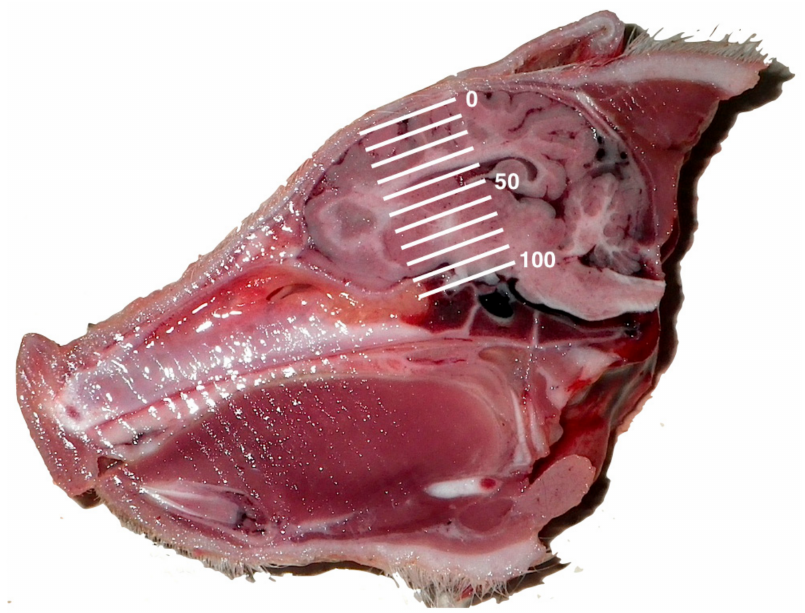
Figure 7. Skull-plate displacement diagram. The level of skull-plate displacement following the shot is expressed as a percentage, with 0 being no displacement and 100% being a case where the skull fragment was observed at the base of the cranial cavity. Each sagittal plane piglet photograph had the scale expanded proportionately for this assessment, with 0 located at the cranial surface and 100% located at the bone peak between the optic chiasma and mammillary